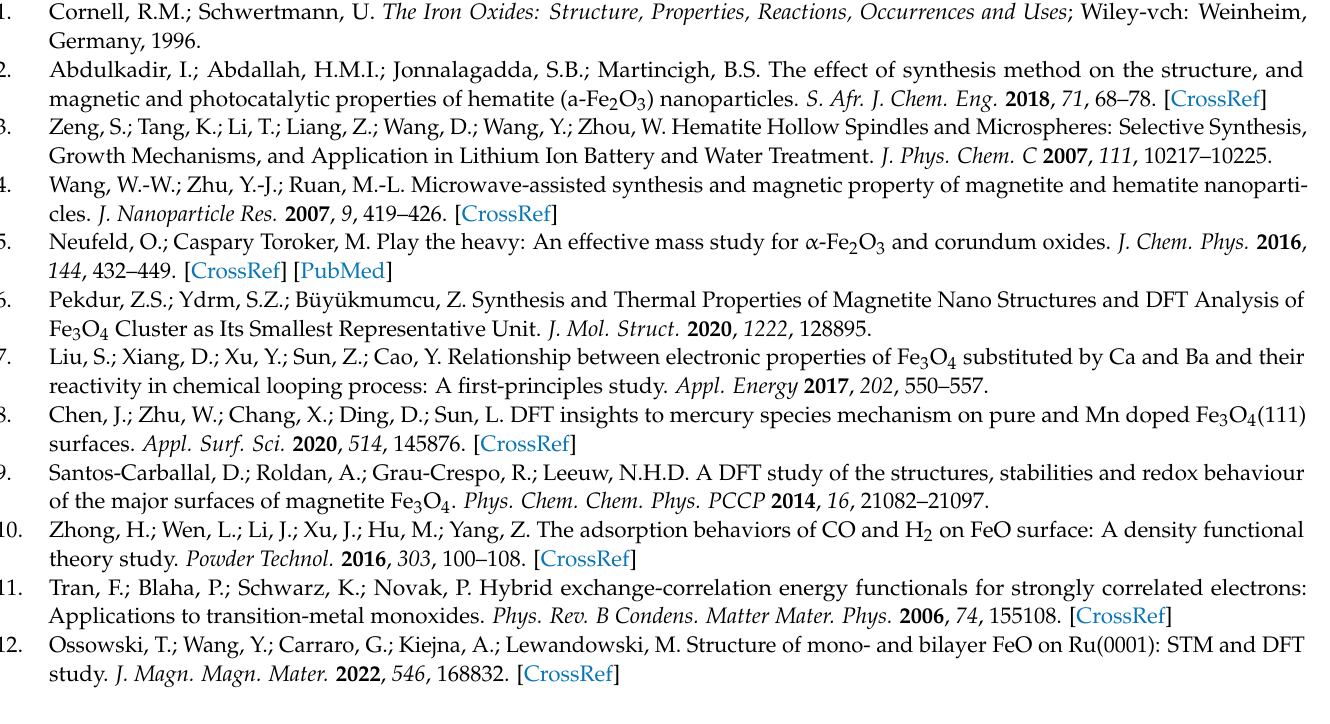
Table S25: Conv_thr results for Fe 3 O 4 ; Table S26: Bate results of Fe 3 O 4 ; Table S27: K-point results of FeO; Table S28: Pseudopotential results of FeO; Table S29: Ecut results of FeO; Table S30: U results of FeO; Table S31: Seaming results of FeO; Table S32: Degauss results of FeO; Table S33: Starting magnetization results of FeO; Table S34: Beta results of FeO; Table S35: Nbnd results of FeO; Table S36: Conv_thr results of FeO; Table S37: Pseudopotential results of FeO*; Table S38: Ecut results of FeO*; Table S39: U results of FeO*; Table S40: K-piont results of FeO*; Table S41: Seaming results of FeO*; Table S42: Degauss results of FeO*; Table S43: Starting magnetization results of FeO*; Table S44: Beta results of FeO*; Table S45: Nbnd results of FeO*; Table S46: Conv_thr results of FeO*. Refs [11,20,30–33,38–49,54,66] are cited in Supplementary